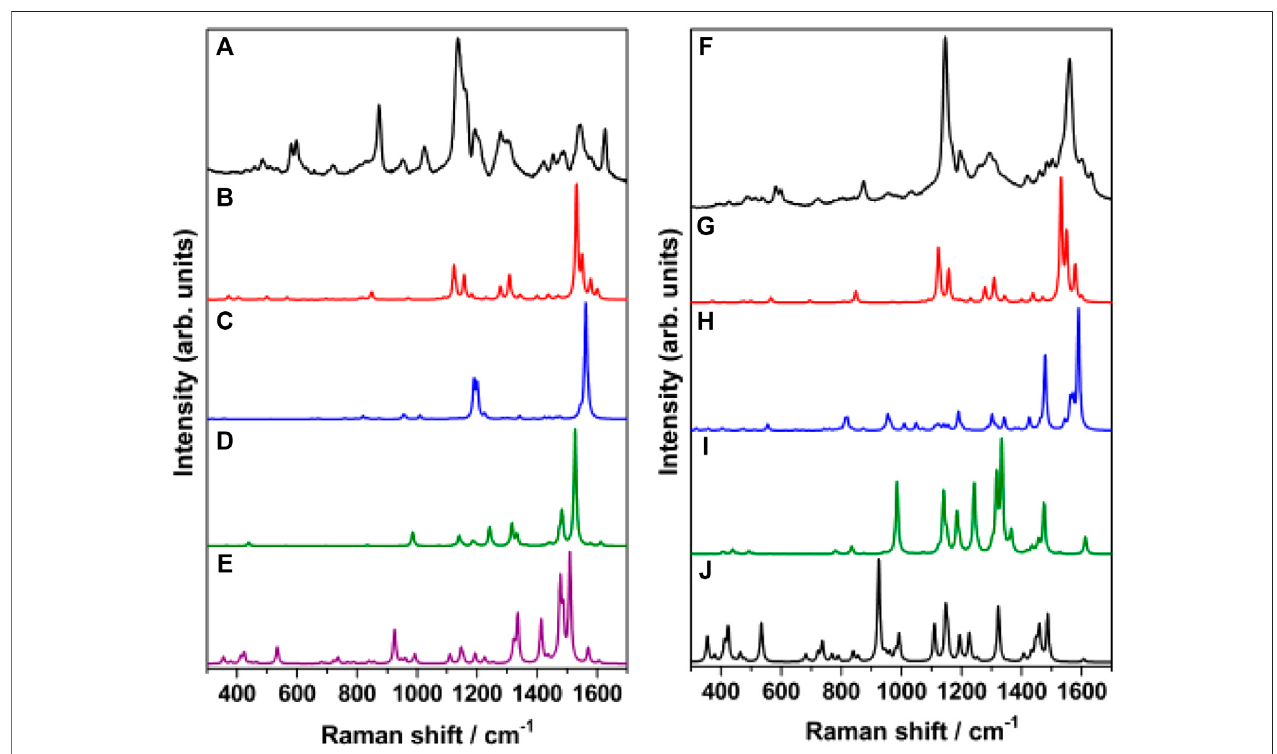
FIGURE 9 | (A) SERS spectrum of merocyanine dye (1 μ M) recorded at 632.8 nm excitation and B3LYP/6 – 31+G* computed Raman spectrum (632.8 nm) of (B) trans -MCH +